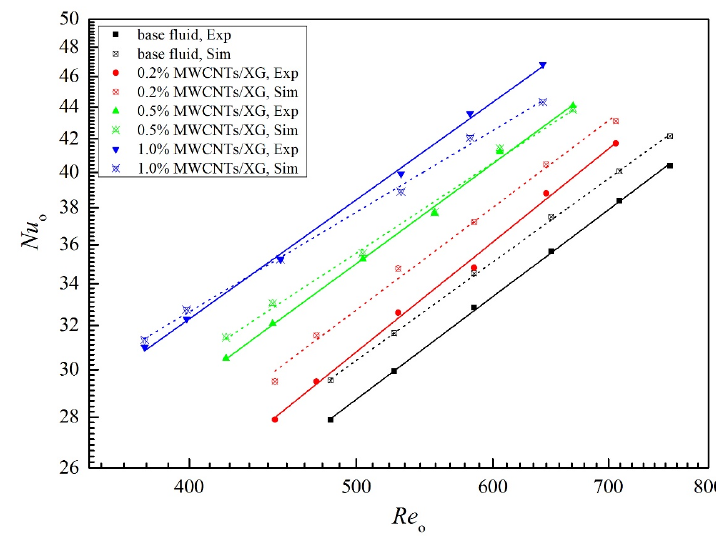
Figure 9. Nusselt number based on experiment and simulation versus shell ‐ side Reynolds number.